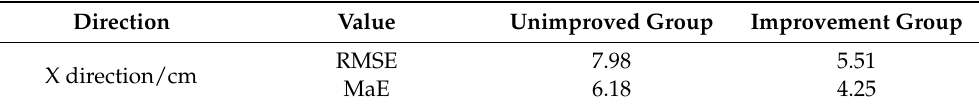
Table 3. Test results.